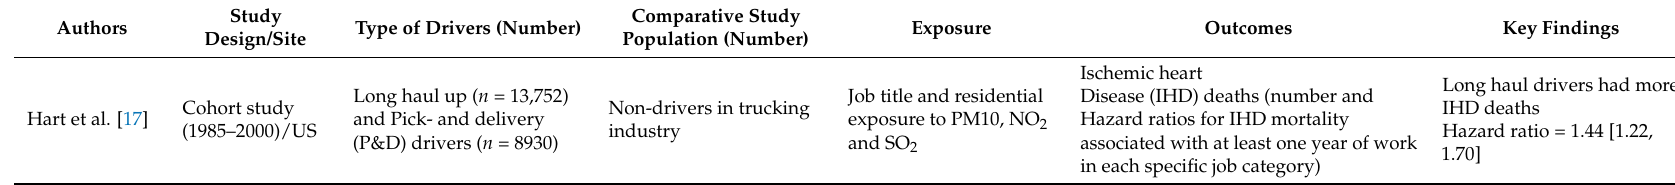
Table 5. Study on truck drivers included in the review.